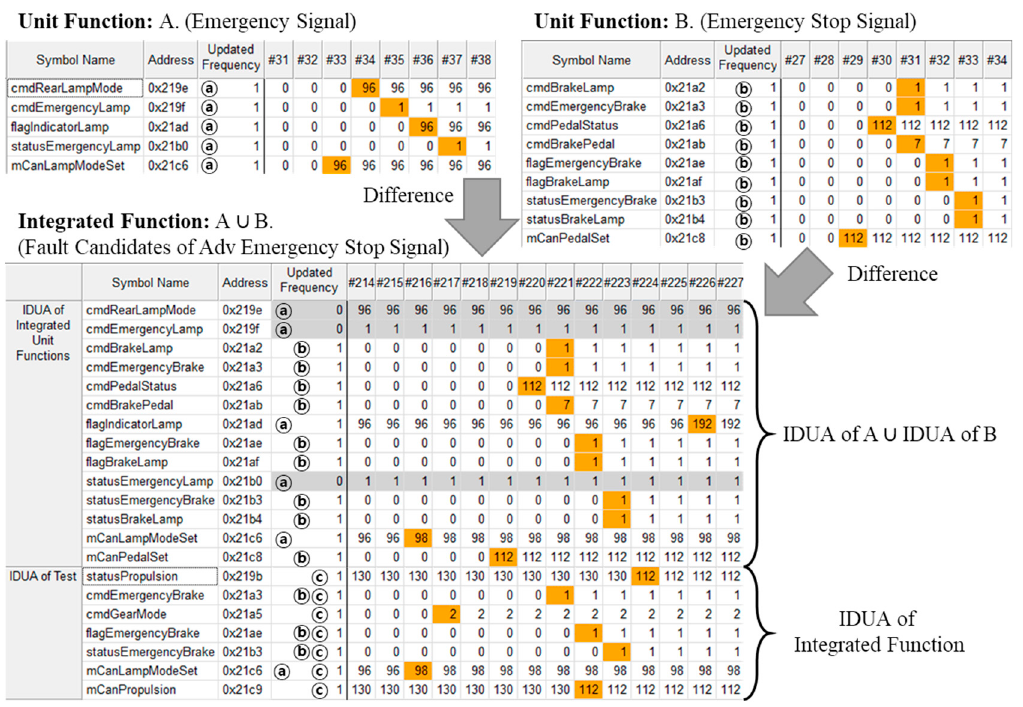
Figure 8. Example of Finding the Faults in the “Adv Emergency Stop Signal”.